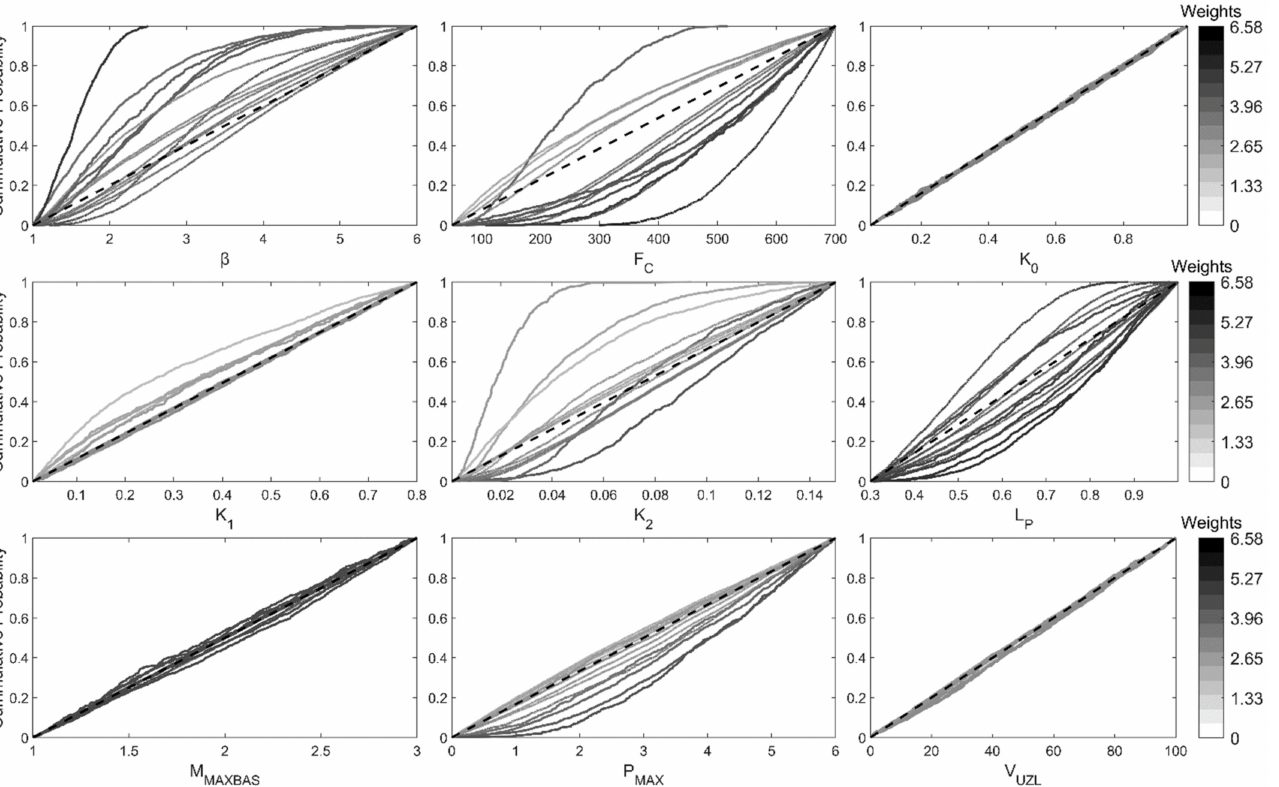
Figure 4. Cumulative distributions of parameters in the 14 catchments that show the probability of identifiability for each parameter on their ranges. The ranges between the most identifiable and poorly identified parameters are indicated through dark gray to light gray colors. The respective identifiability is also shown by the weight (1/CV) of parameter distribution. Where the dark gray color shows the catchment number with the most identifiable parameter. Parameters such as K 0 and V UZL are not identified through their parameter ranges, therefore the median of the parameter was used for the regression